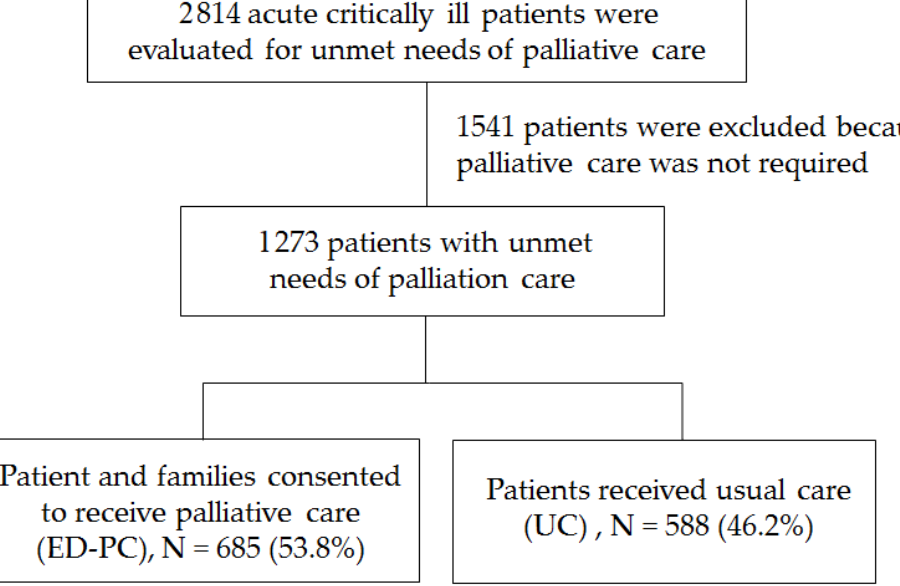
Figure 1. Flowchart of study patients receiving palliative care or usual